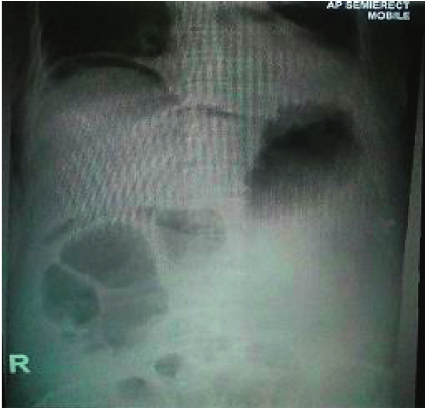
Figure 6: Plain X-ray abdomen; gas under diaphragm positive, gas- filled distended stomach, and some bowel